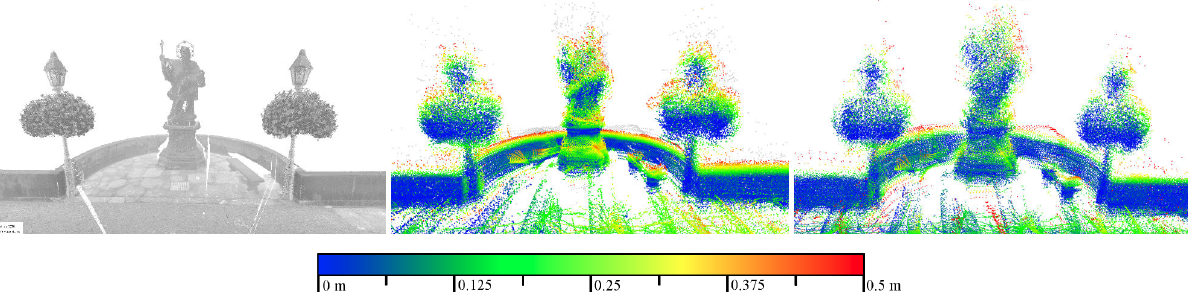
Figure 12. A closer look at the bridge saint John of Nepomuk , third from left in Fig. 11 (top). Left: reference data from the Riegl VZ-400 laser scanner. Center: final point cloud of RADLER. Right: final point cloud using the Kalman filter. The color shows the point-to-point distance respective to the provided color gradient from 0 m to